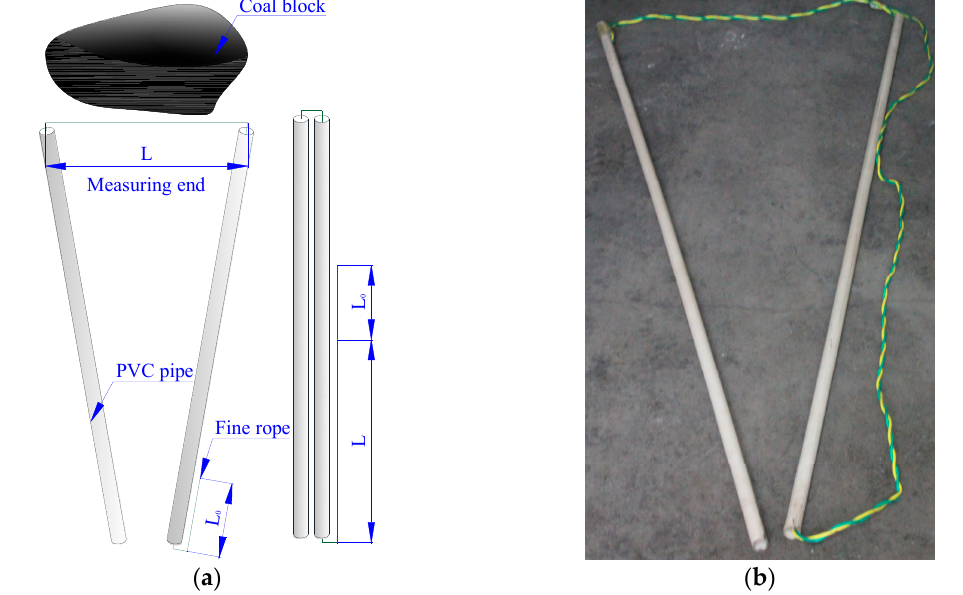
Figure 11. Method for measuring caving block size of top coal: ( a ) Measurement principle diagram and ( b ) Physical map.